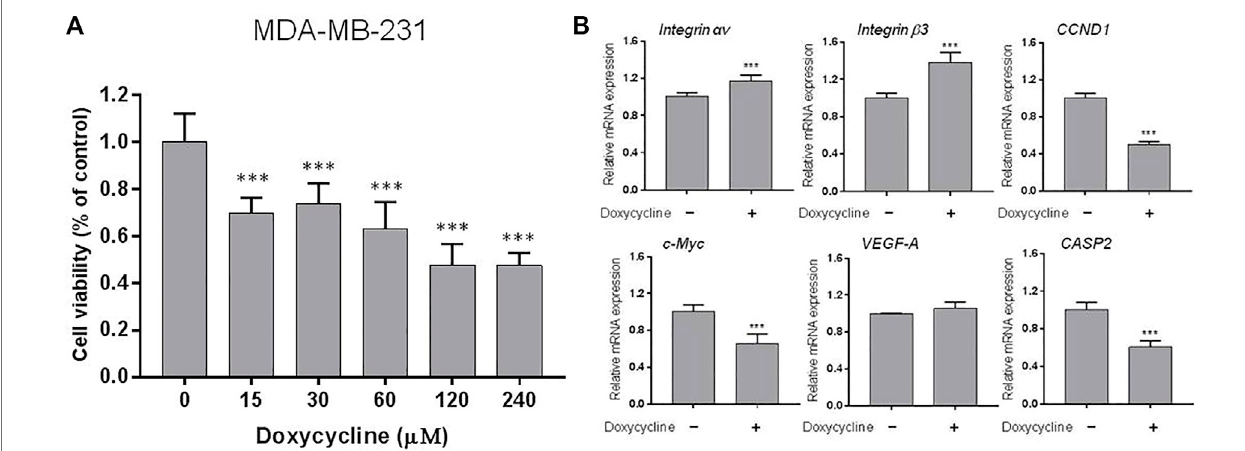
FIGURE 2 | Doxycycline induces anti-proliferation and gene expression in ER-negative breast cancer cells: (A) MDA-MB-231 cells were seeded in 96-well plates and treated withdifferentconcentrationsofdoxycycline (0,15, 30,60,120,240 µM)for 72 h.Cell via bilitywasexamined withanalamarBlue ® assay. N=6.ANOVAwas usedtoassessstatisticalsigni fi cance.Datawereexpressedasmean±SD;*** p < 0.001,comparedtotheuntreatedcontrol; (B) Cellswereseededin6-wellplates.Then, cellswerestarvedfor24 handtreatedwithdoxycycline(60 µM)for24 h.TotalRNAwasextractedandqPCRanalysiswasperformed.Thenumberofindependent experiments ( n ) = 3. A Student ’ s t-test was used to assess statistical signi fi cance. Data are expressed as mean ± standard de via tion; *** p < 0.001, compared to the untreated control.